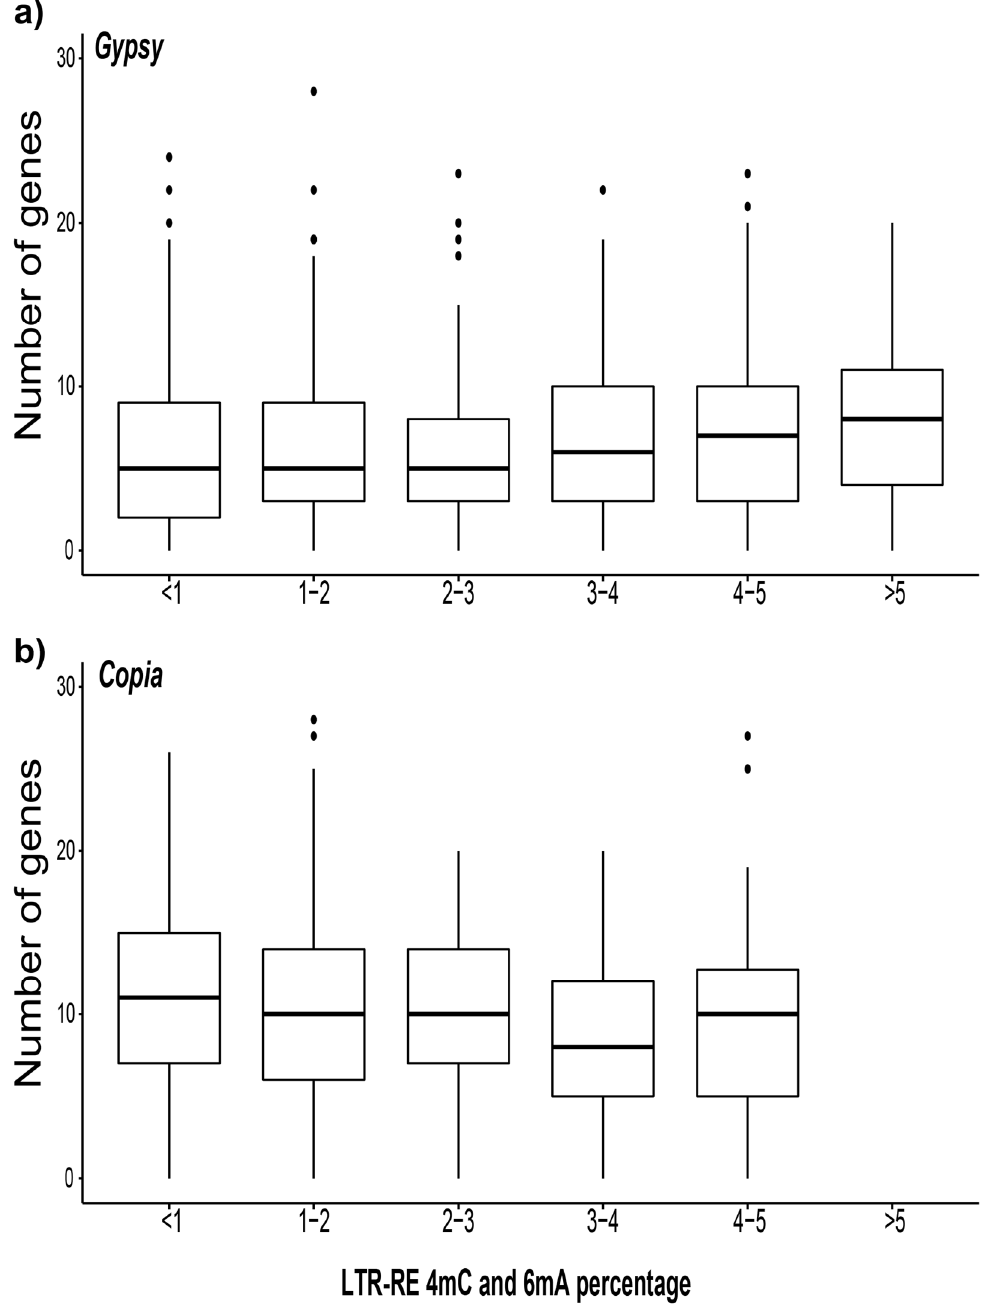
Figure 5. Number of genes proximal to the Gypsy (a) and Copia (b) full-length LTR-REs, subdivided into classes according to their unconventional methylation percentage. The LTR-REs were clustered in six groups according to their methylation levels (from <1% to high, >5%); the dots represent outlier values.